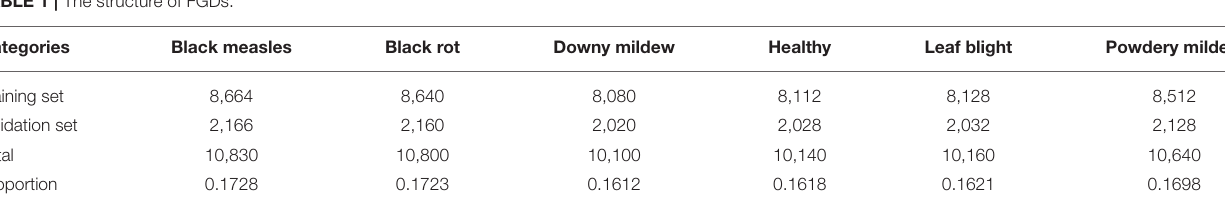
TABLE 1 | The structure of FGDs.